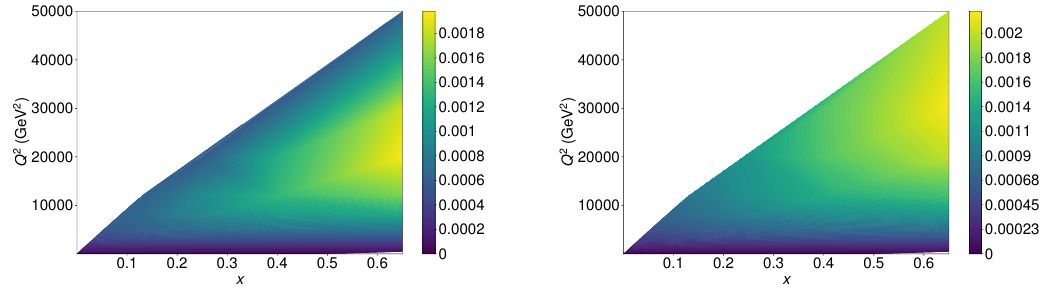
Figure 24 . Contour maps indicating the value of the EFT correction, K EFT ( ˆ W, ˆ Y ) − 1 in eq. (3.9), for the DIS reduced cross sections as a function of x and Q 2 for two representative values of the EFT parameters: ˆ W = − 10 − 4 (left panel) and ˆ Y = − 10 − 4 (right